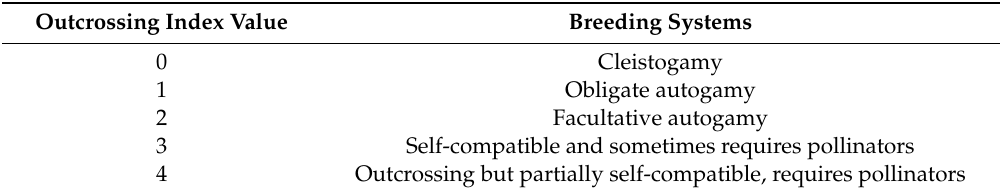
Table 3. Breeding systems as determined by Dafni’s outcrossing index